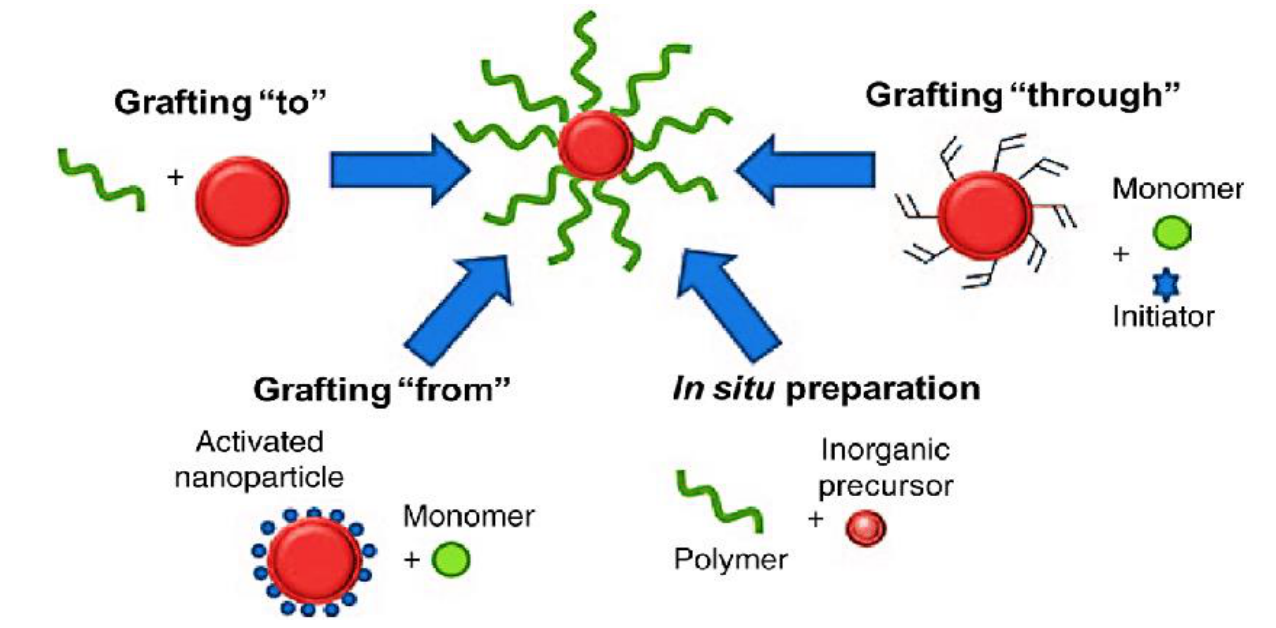
Figure 6. Schematic illustration of polymer grafting approaches: “grafting from”, “grafting to”, “grafting through” and “in situ” preparation in the pre sence of an inorganic precursor.